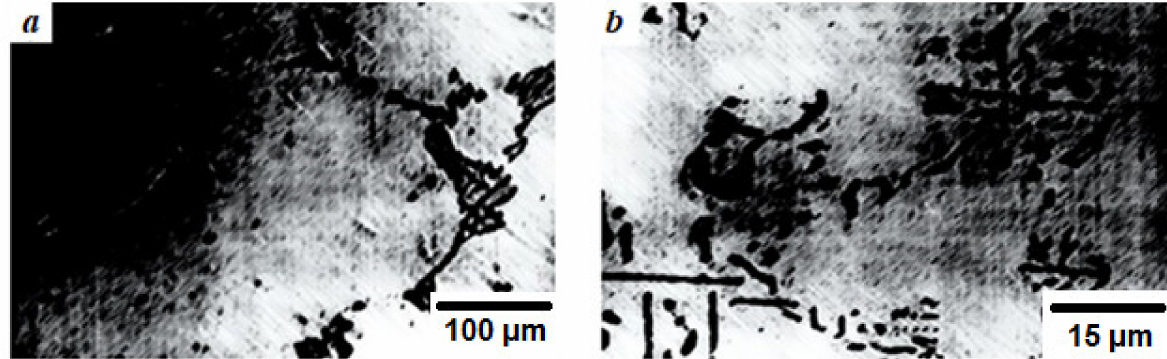
Figure 4. Morphology of carbide precipitates in the structure of the studied heat-resistant alloy: ( a ) 50 × and ( b ) 400 ×